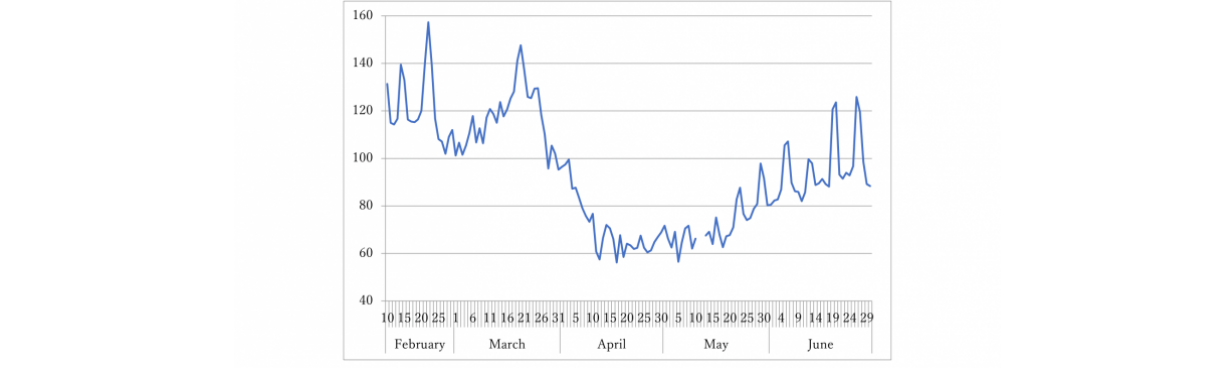
Figure 1. Apple data in Japan from February 10 to the end of June 2020. The line represents the ratio of the number of trips from homes to activities by transportation type (driving, transit, and walking) on January 13, 2020. Apple data for May 12 and 13, 2020, were missing. The prediction in the period was also missing.